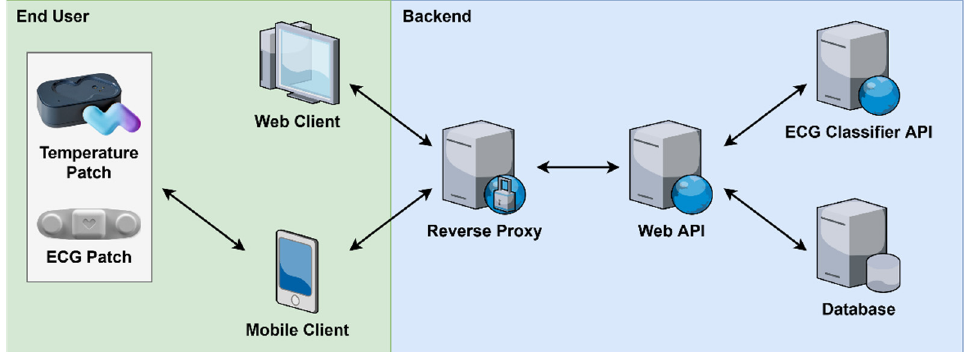
Figure 1. Overview of system